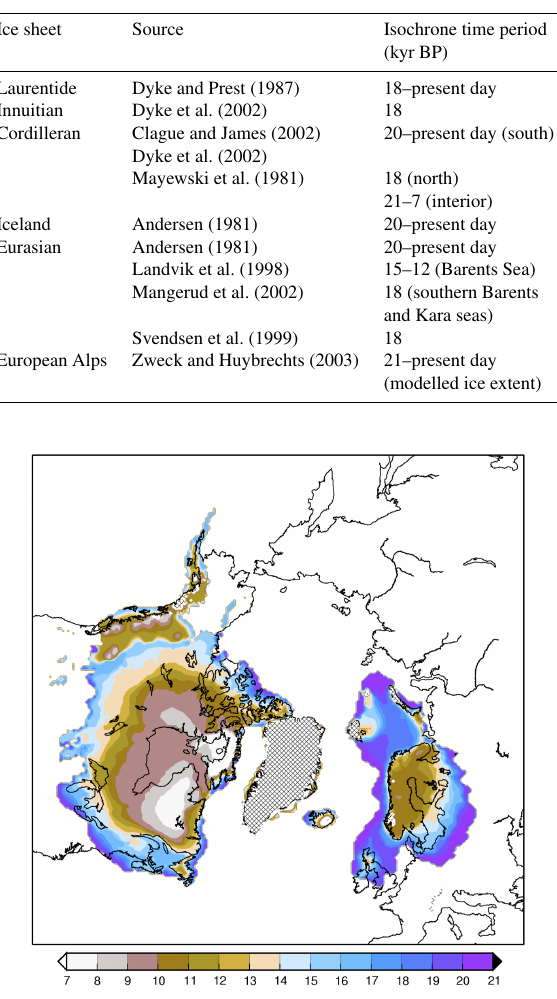
Figure A1. Interpolated ice sheet extent during the last deglacia- tion for the Northern Hemisphere ice sheets as a function of time (kyrBP). Hatched regions indicate present-day